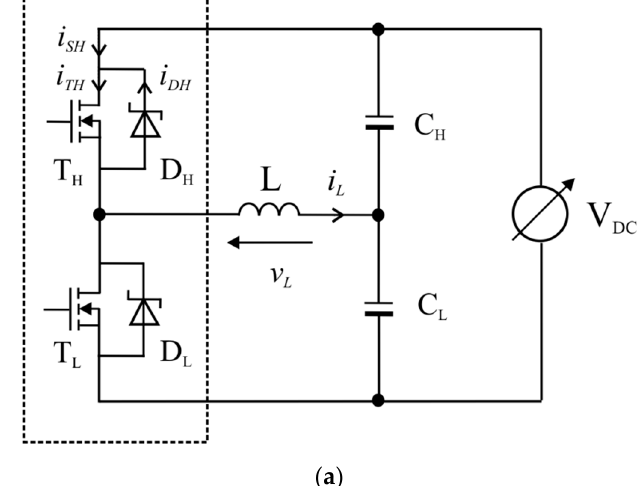
Figure 5. Square-wave-controlled half-bridge circuit: idealized waveforms of the transistor T H ( i T ) and diode D H ( i D ) current for the first half of the switching period T SH . Presented waveforms suggest that the majority of the current, and in consequence, conduction power losses, are dissipated in the transistor—similarly to a three-phase inverter. Moreover, the distribution of the losses between the two devices in the switch depends only on the amplitude of the load current I PK and the parameters of the diode and transistor static characteristics ( r ON , V TO , r D ) influenced by the temperatures. Thus, there is a chance to set a given value of the power losses in either the diode or in the transistors. Even if possible, setting the precise values in both devices requires further effort. In order to change this distribution and push more losses from the transistor towards the diode, the simplest method is to adjust the length of the time t 4 —or, in other words, the duty ratio of the transistors: